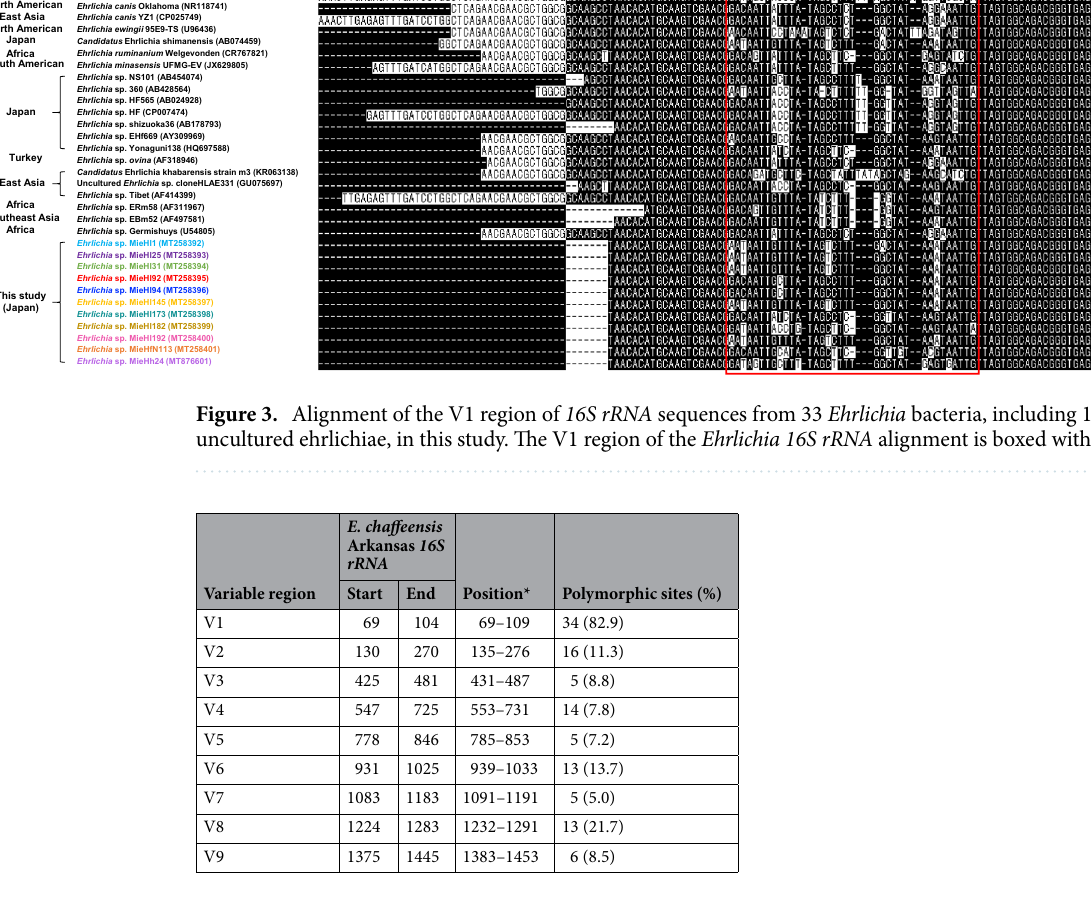
Table 2. Polymorphic sites of V1–V9 regions in Ehrlichia 16S rRNA . *The position on the alignment with gaps in Fig. 3 and Supplementary Fig. S1 is shown here.